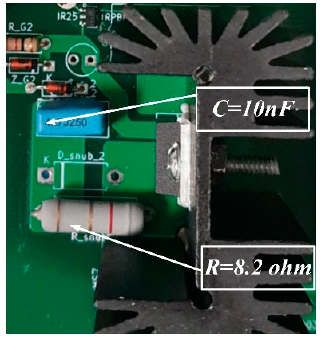
Figure 11. Snubber used in the prototype.